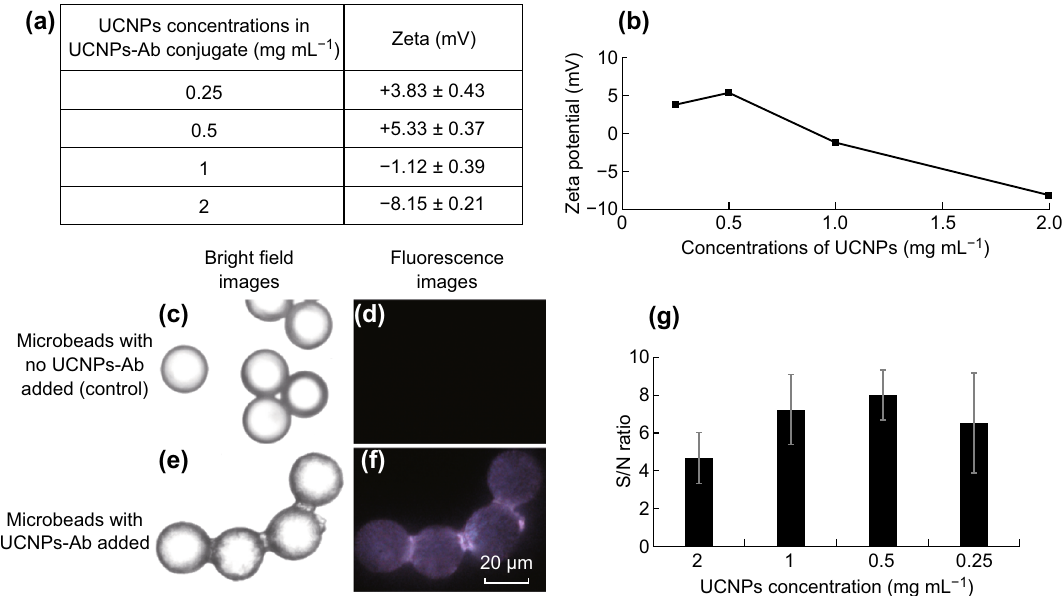
Fig. 6 a Different surface charge of UCNPs-Ab conjugates at different concentrations of UCNPs, and b corresponding graph for surface charge versus UCNPs concentrations in UCNPs-Ab conjugate. c, e Bright field and d, f corresponding fluorescent microscopy images at 40 9 magnification of NaYF 4 :YbTm microbeads with and without UCNPs-Ab, and g corresponding S/N ratios of UCNPs-Ab at different concentrations of UCNPs used in the conjugation reaction (data represent mean ± SD; n = 20